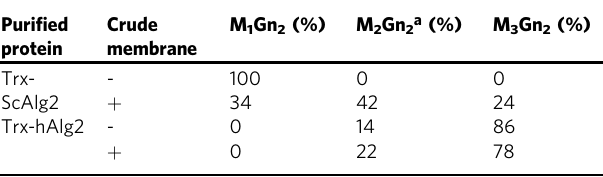
Relative percentage was calculated by dividing the area of each corresponding oligosaccharide peak by the total area of all peaks (×100) in the UPLC chromatograms are shown in Fig. 4b. a